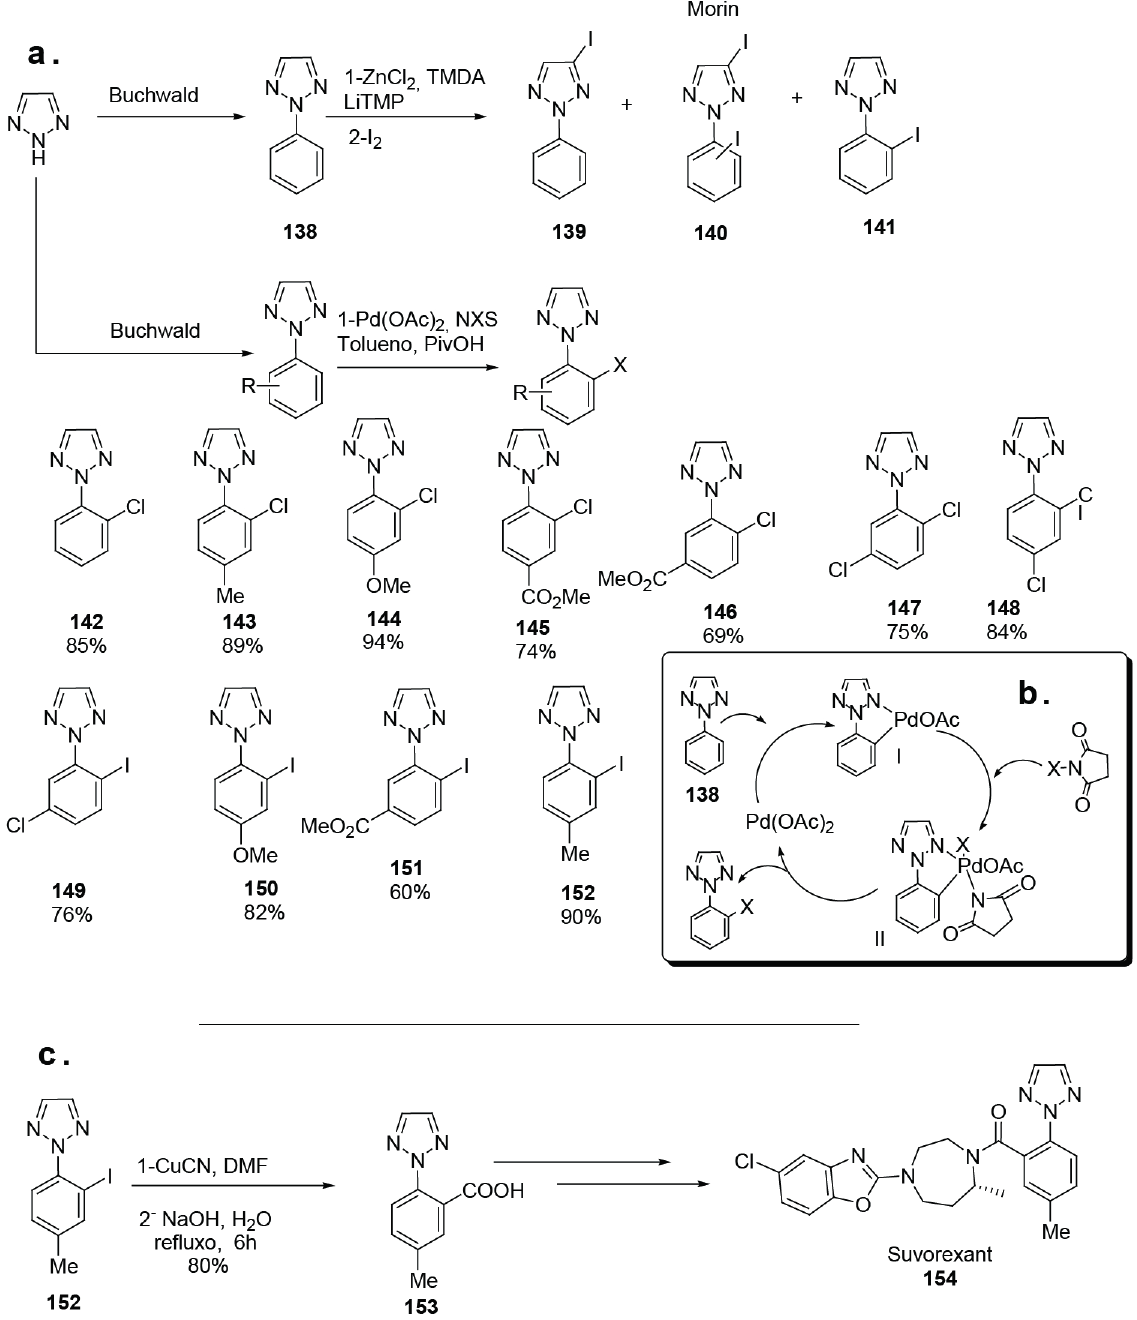
Figure 21 - a ) The 2’ halogenation of 2-aryl-1,2,3-triazoles. b ) A simplified catalytic cycle showing the ortho- palladation directing ability of the 123-triazole core. c ) Application of this reaction in the synthesis of the 1,2,3-triazolic core of